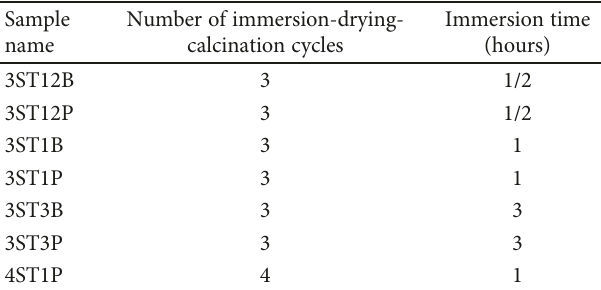
Figure 2: 2,4-Dinitrophenylhydrazine general reaction with aldehyde functional groups. Table 1: Nomenclature of synthesized materials (B by ultrasound bath and P by stirring